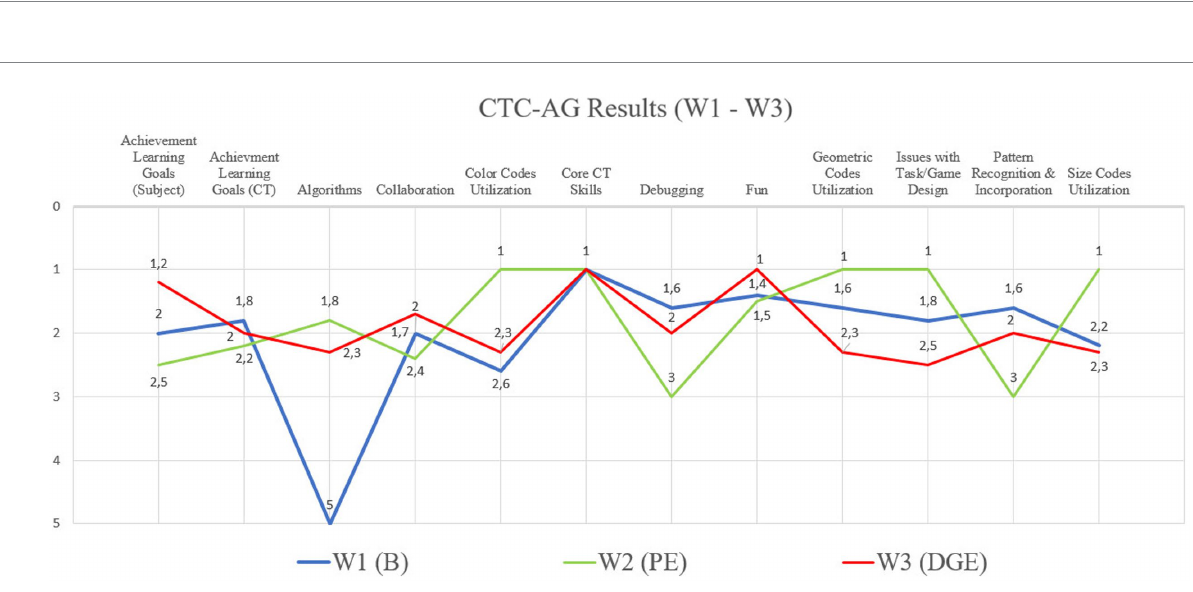
FIGURE 7 Results of the comparison of all participating groups from workshops 1, 2 and 3. The Y-axis shows the grades 1–5, according to the researcher, and the X-axis is showing excerpts of the CTC-AG